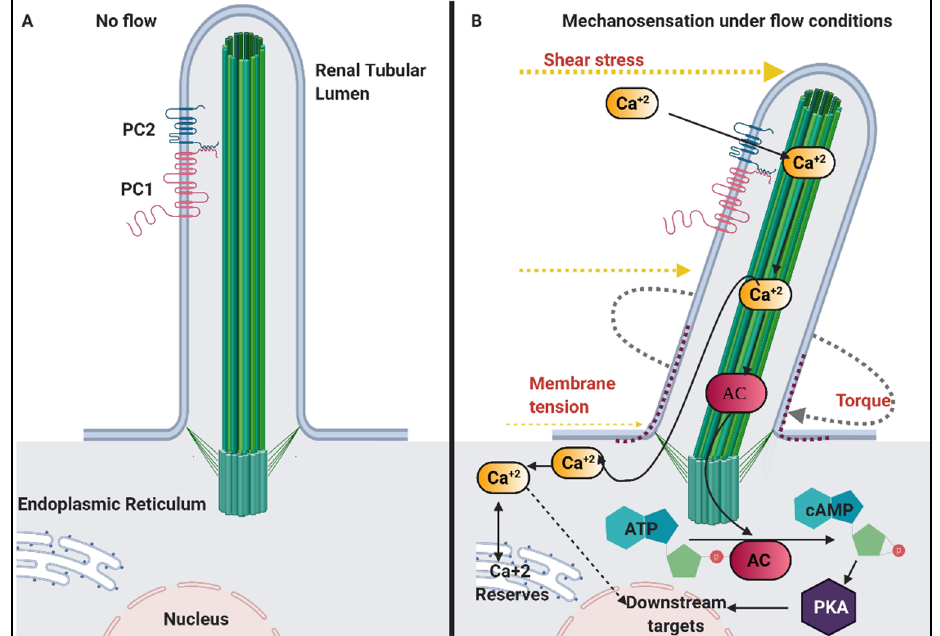
Figure 3. Molecular processes governing mechanosensation in primary renal cilia: ( A ) The renal cilium projects into the lumen of the renal tubule where it can sense physical forces resulting from luminal flow. The polycystin complex (made of polycystins 1 and 2 (PC1/PC2)) located in the ciliary membrane helps transducing these mechanical cues. ( B ) The cilia senses mechanical forces like shear stress, membrane tension or torque under flow conditions. This stimulus is hypothesised to activate PC2, resulting in an influx of Ca 2+ which in turn activates adenyl cyclase (AC). AC converts adenosine triphosphate (ATP) to cyclic AMP (cAMP). cAMP acts as a signalling molecule for protein kinase-A (PKA) which modulates the expression of downstream proteins. The influx of Ca 2+ also regulates intracellular calcium homeostasis, thereby affecting the regulation of calcium reserves from the endoplasmic reticulum. (Modified and redrawn using BioRender.com [150,151] ).